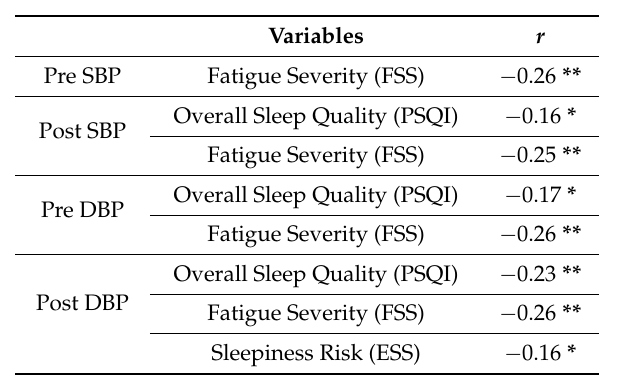
Table 2. Significant partial correlations between cardiac measures and other variables in corrected model +